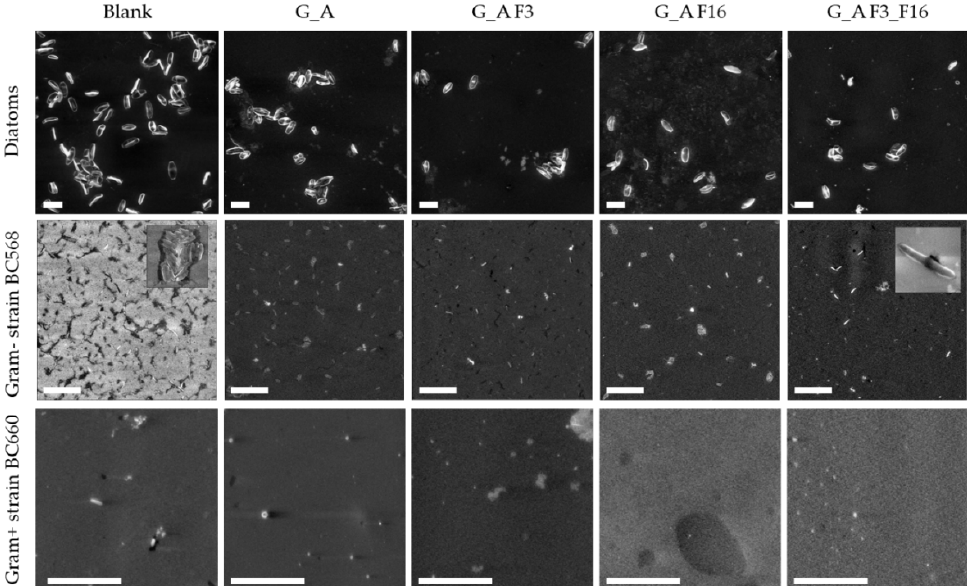
Figure 15. Representative SEM micrographs of bare and functionalized glass substrates after exposition to different microbial suspensions. All scale bars are 20 µm; insets are 20 by 20 µm (on the left, showing clustered bacteria) and 2 by 2 µm (on the right, showing an isolated bacterium).